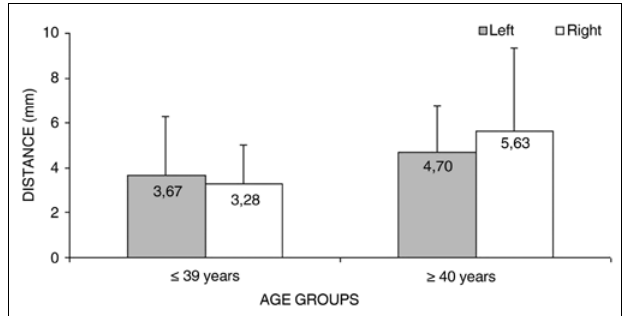
Figure 3. Measurement 2 relative to age and side, in mm (mean ± standard deviation) - measurement 2 (the shortest transverse measu- rement from the superior thyroid artery to the EBSLN along a tangent to the inferior border of the thyroid cartilage).